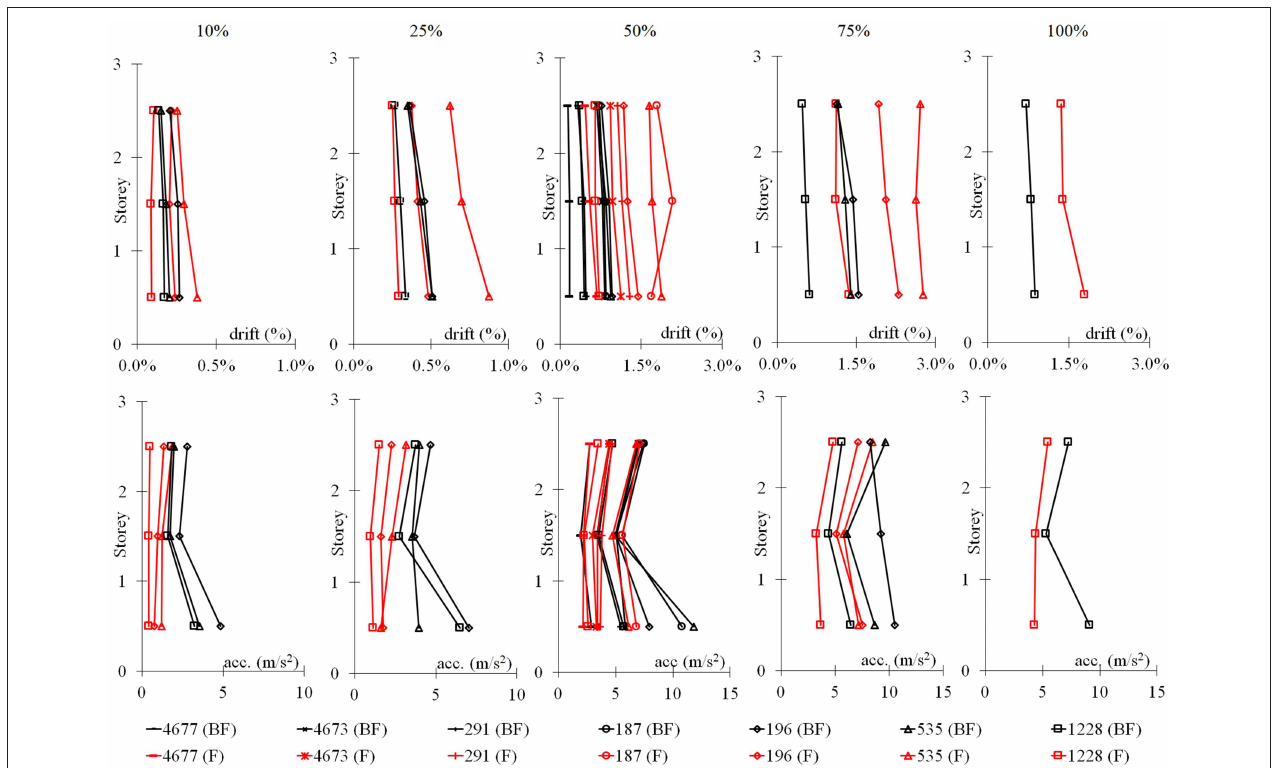
FIGURE 10 | Maximum inter-story drift and maximum acceleration at each story from all experimental tests.